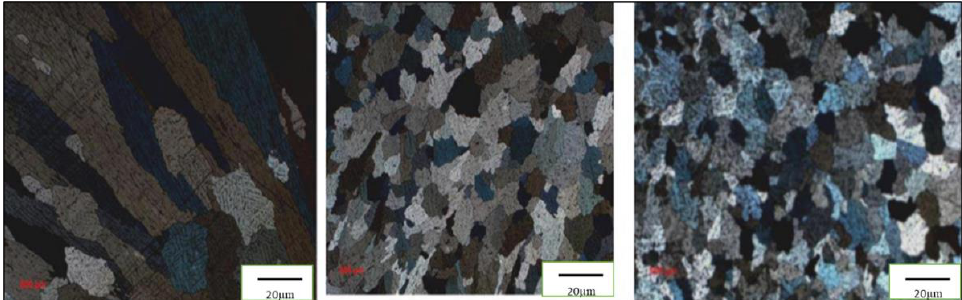
Figure 5. The evolutions in the grain sizes vs. the Mg content percentages in Al (1050) alloy: ( a ) 0%; ( b ) 1%; ( c ) 5%.